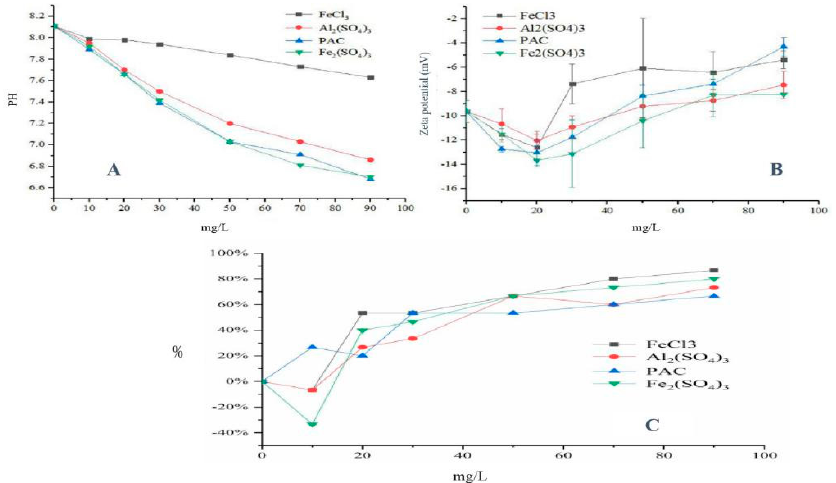
Figure 2. ( A ) Effect of coagulants on pH; ( B ) changes in zeta potential; ( C ) removal effects of coagulants on turbidity.